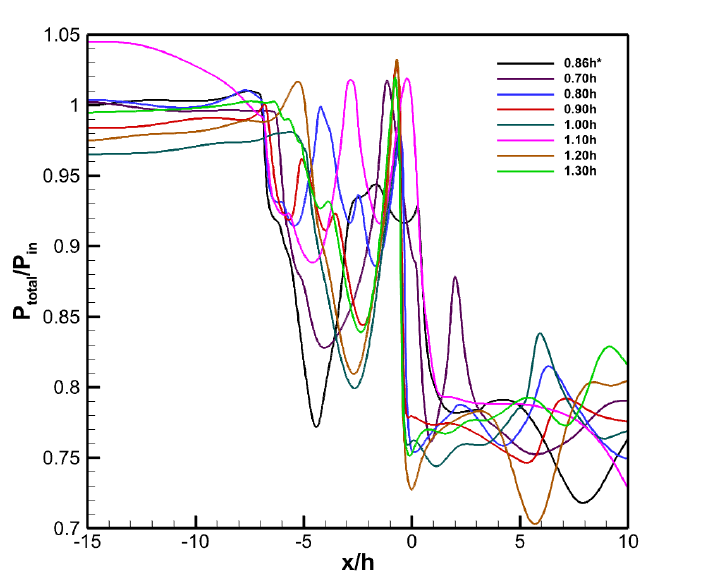
Figure 10. Instantaneous total pressure along the centerline normalized with the total inlet pressure, P total , Baseline = 131,829.6584 Pa for curvature